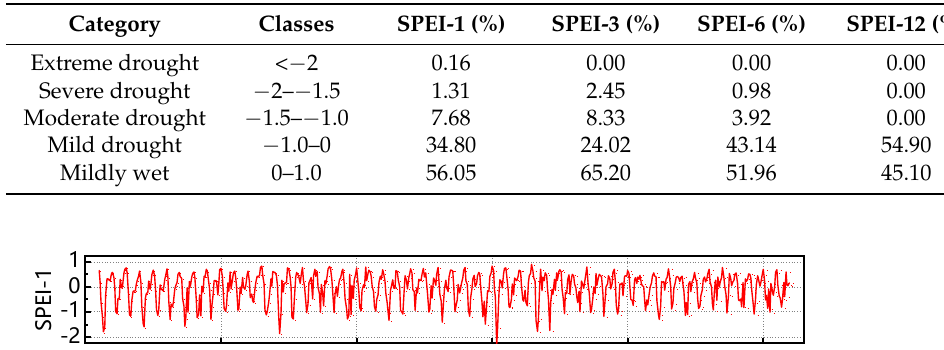
Table 4. Classification of the SPEI on the TP in 1966–2016.